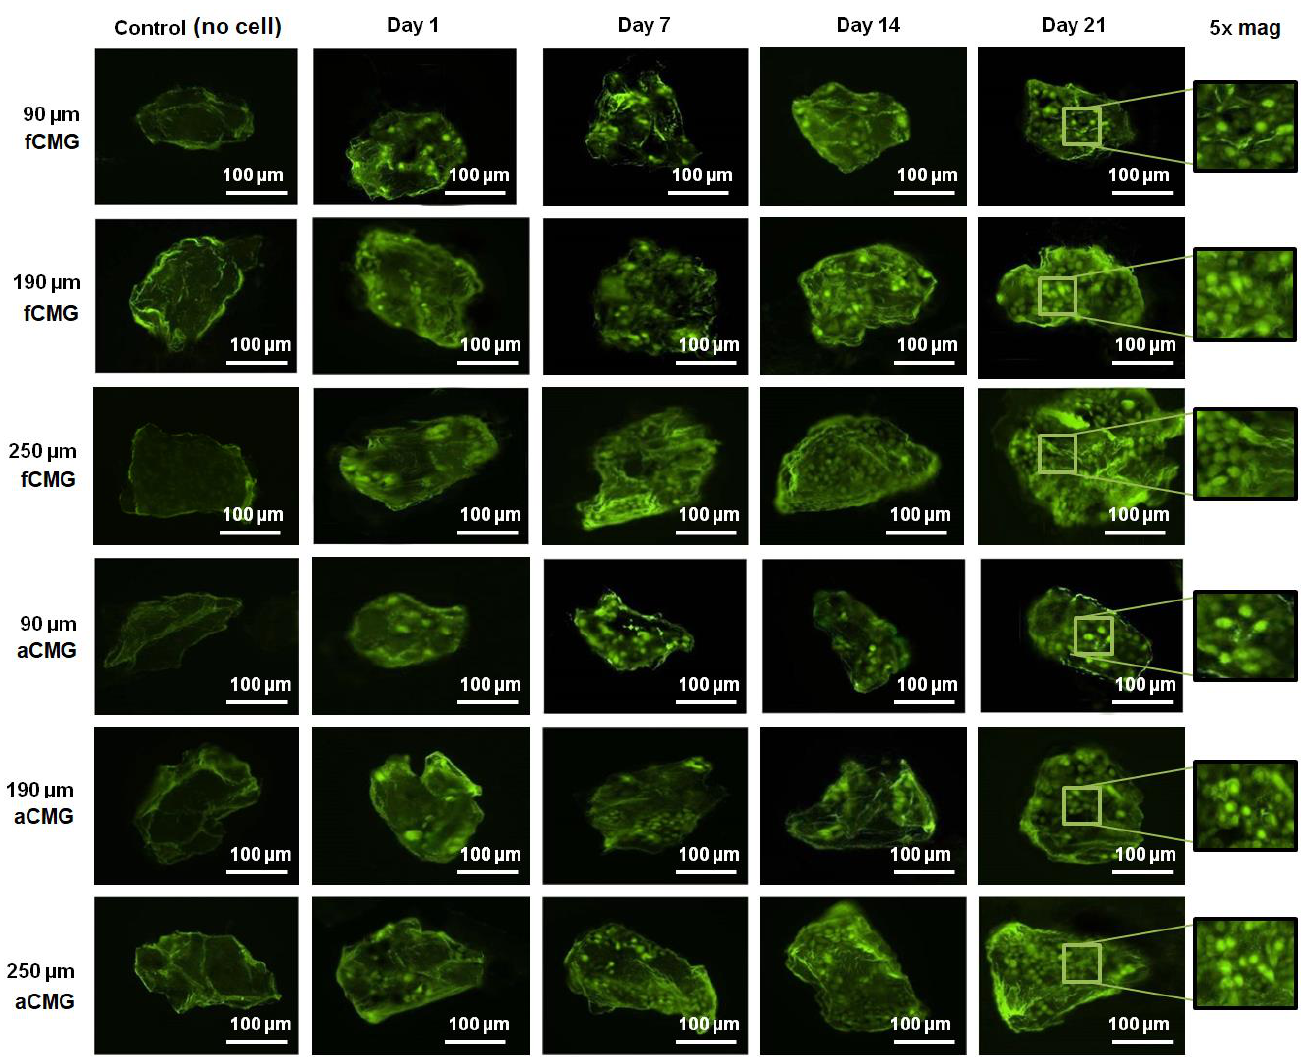
Figure 3. The fluorescent images of live (green) and dead (red) cells in a randomly selected microgel from fetal and adult CMG-MSCs in basal medium as a function of culture time (1, 7, 14, and 21 days) for CMG sizes of 90, 190, and 250 μm; the control group ( leftmost column) was the image of a microgel without hMSCs incubated in basal medium with culture time; the images in the last column on the right re 5× magnification of the 21 days images. The scale bar in the images is 100 μm.